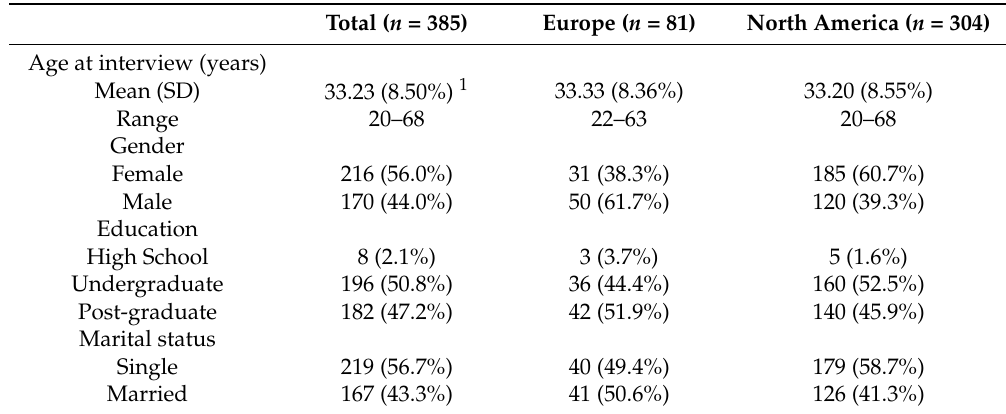
Figure 2. Participants flow diagram. Table 1. Sociodemographic